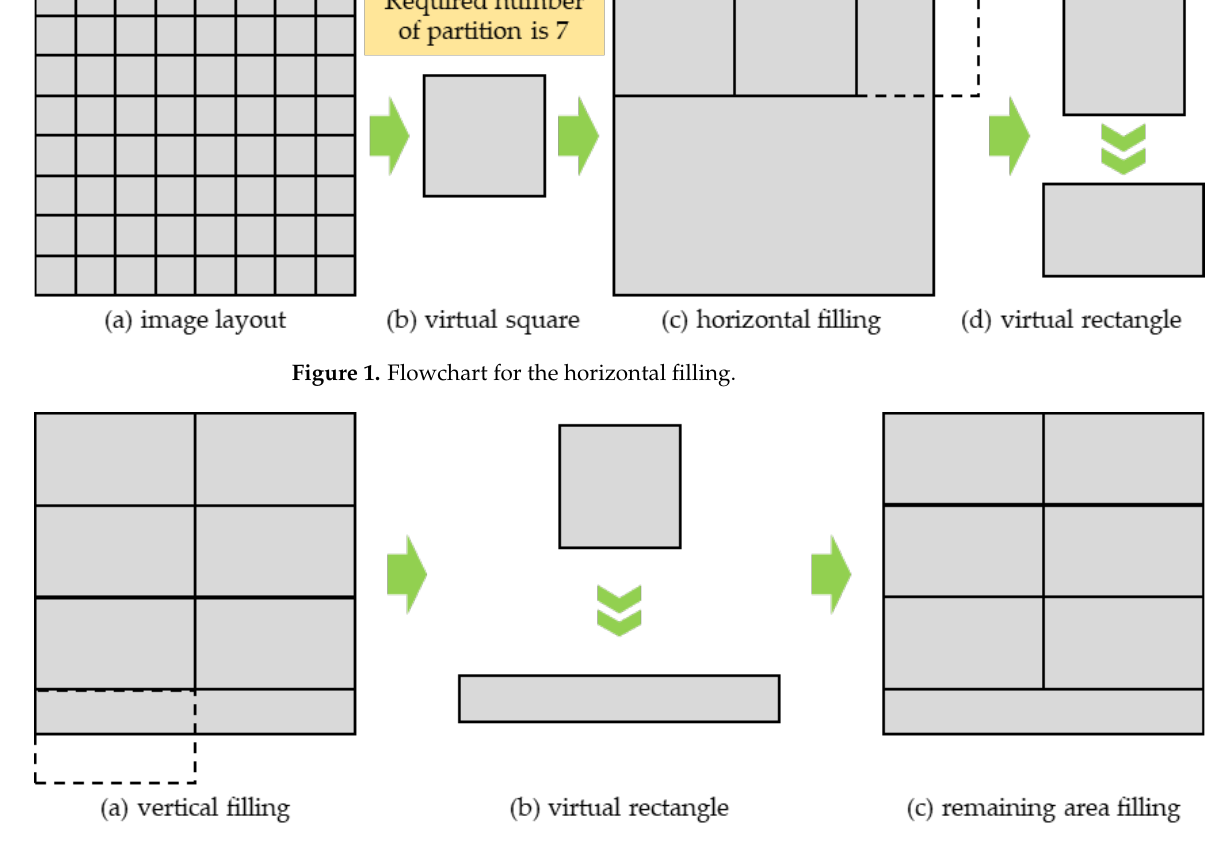
Figure 2. Flowchart for the vertical filling.